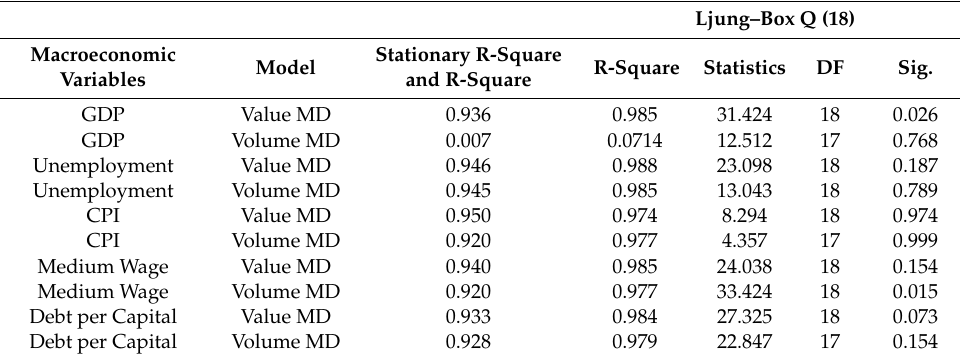
Table 1. Correlation of the model for Europe.